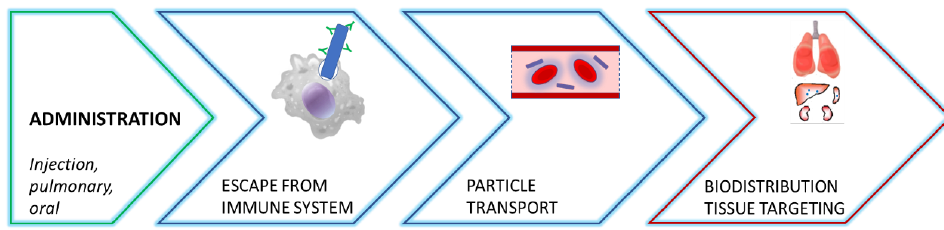
Figure 3. Different steps from nanocarriers administration to tissue targeting. Table 2. Effect of nanocarriers shape on biological processes compare to sphere counterparts. Effect on biological processes Ref. Non-Spherical Nanocarriers Effect on Biological Processes